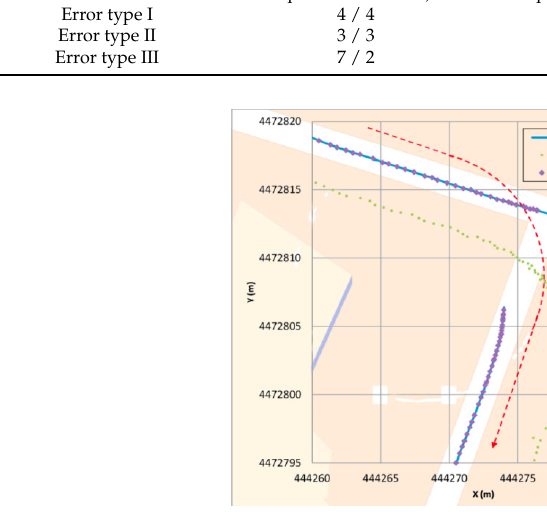
Figure 6. Type I error example.